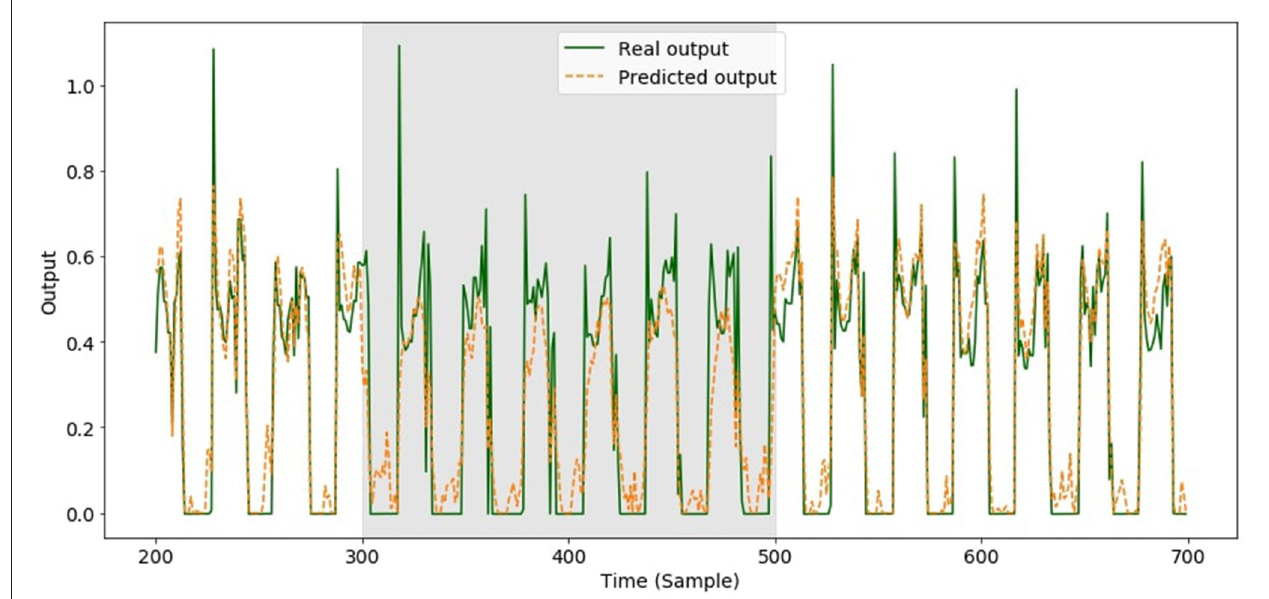
FIGURE 5 | Predicted GRFs of front right leg when a fault was introduced in both front right leg joints over 200 samples (gray area from 300 to 500). The training set consisted of data that included the faults.